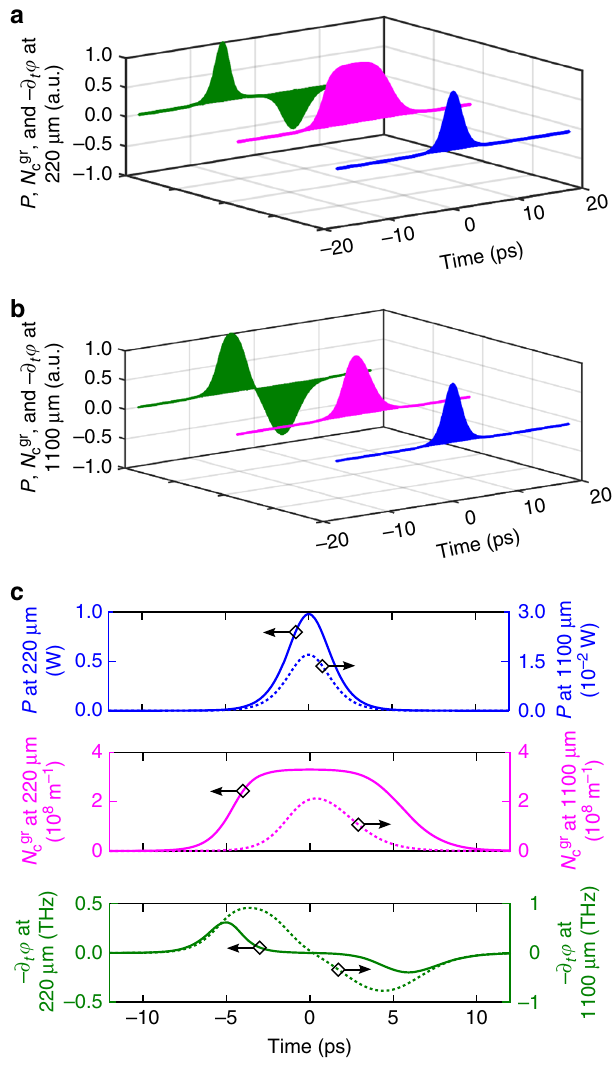
Fig. 4 Time evolution of the optical and carrier-related quantities at different distances in the graphene-covered SiO 2 -core waveguides: 3D illustration of the time evolution of the optical power P (blue), the graphene-generated free-carrier density N gr c (magenta), and the instantaneous frequency − ∂ t φ (green) at a 220 μ m and b 1100 μ m propagation distance. Both 3D graphs show normalized quantities. c Time evolution of the same quantities, but with the numerically obtained absolute values displayed and with the solid and dashed curves corresponding to, respectively, 220 and 1100 μ m propagation distance